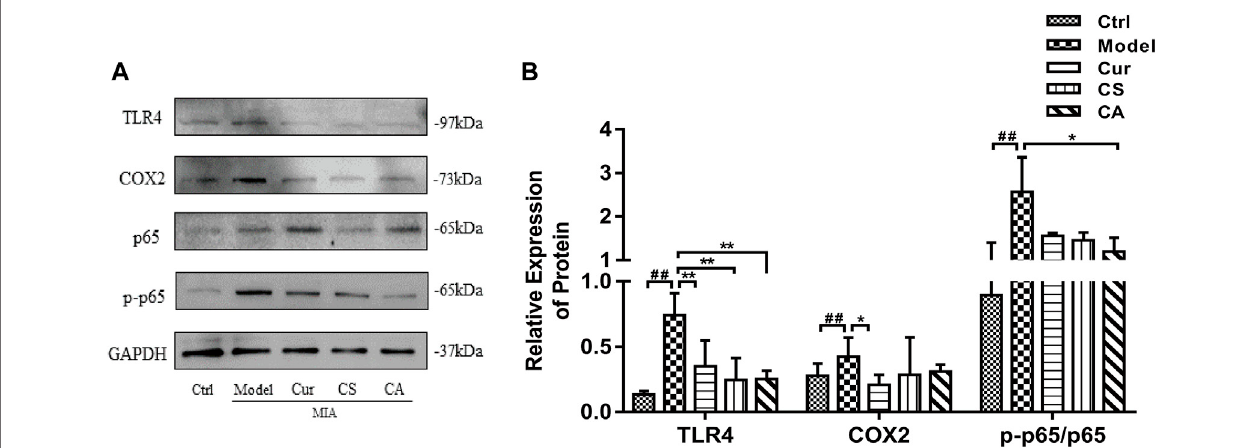
FIGURE6| DeterminationoftheeffectsofCur,CS,andCAontheproteinexpressionofTLR4,cox-2,NF- κ Bp65,andp-p65inKOArats. (A) Westernblotanalysis of TLR4, cox-2, NF- κ B p65, and p-NF- κ B p-p65 expressions in cartilage. (B) Relative expression of TLR4, cox-2, and p-NF- κ B p-p65 divides NF- κ B p65 in cartilage. Data are presented as the mean ± SD ( n = 3). ## p < 0.01 vs. Ctrl group; * p < 0.05 vs. model